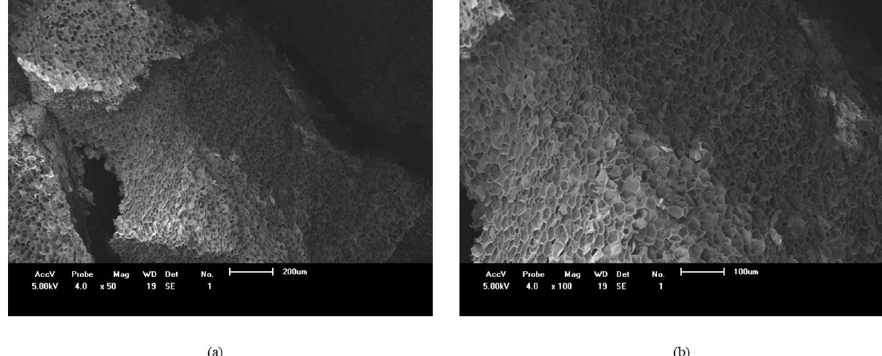
Figure 6. Morphological structure of cork: magnification 50x (a) and (b)